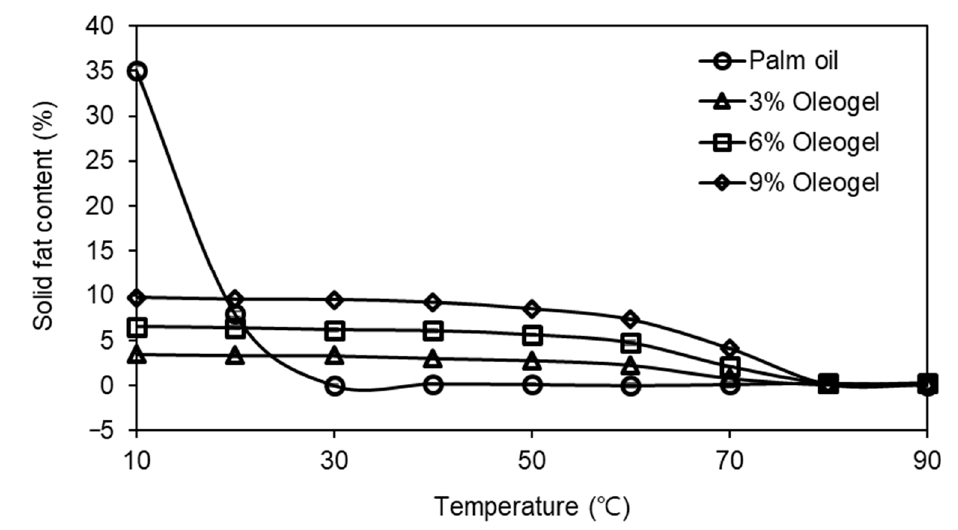
Figure 1. Solid fat content of palm oil and oleogels.